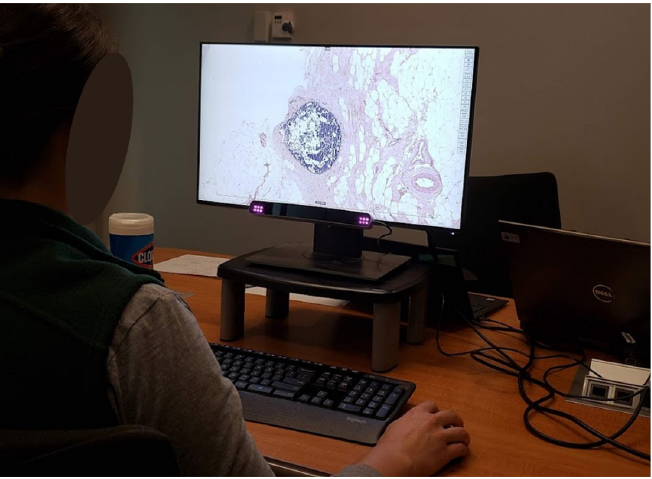
Fig 1. Experimental apparatus. A participating pathologist (face obscured for privacy) interpreting a breast biopsy image during the study, navigating the image by using the computer mouse to click-drag (panning in XY space) and scroll (zooming in Z space). The remote eye tracking device is attached to the bottom of the computer monitor.